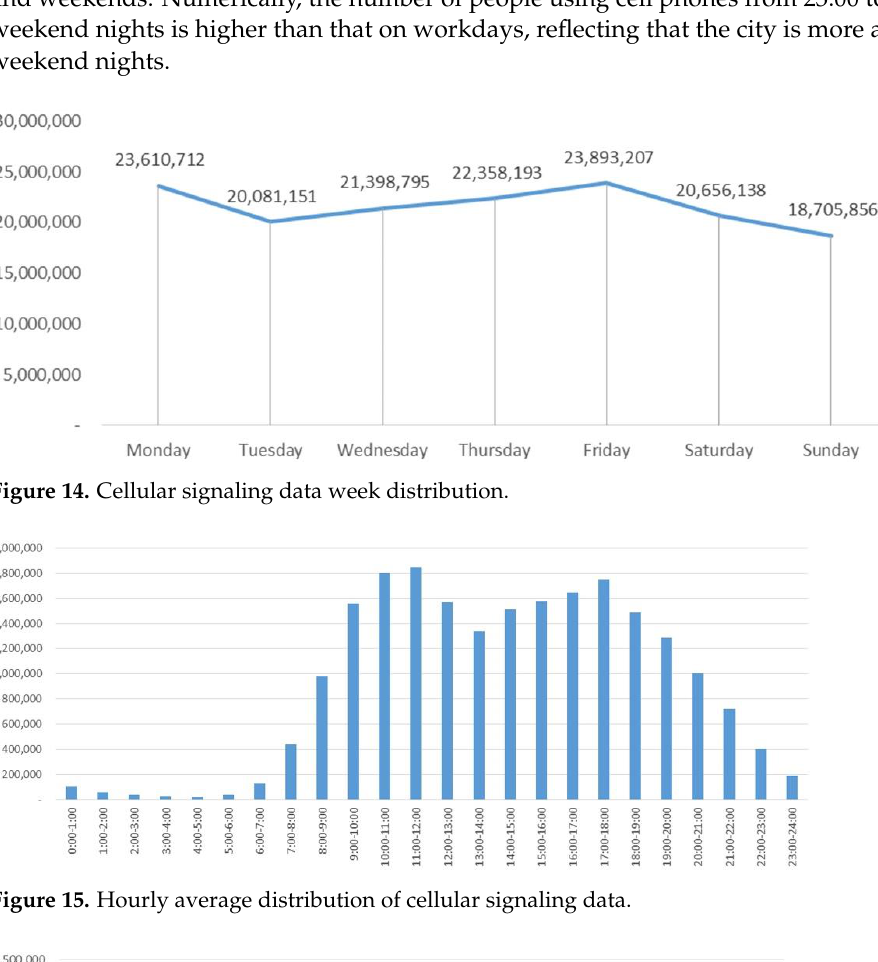
( b ) Figure 13. Block environment perception. ( a ) Green-looking ratio; ( b ) sky view. 4.2. Block Vitality Features